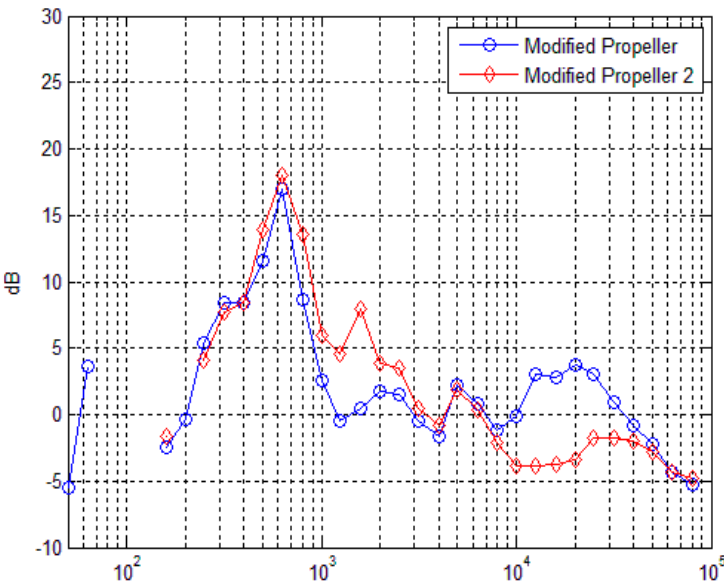
Figure 19. Noise reduction with application of pressure relief holes in Third Octave band for condition V2, measured at hydrophone H3.